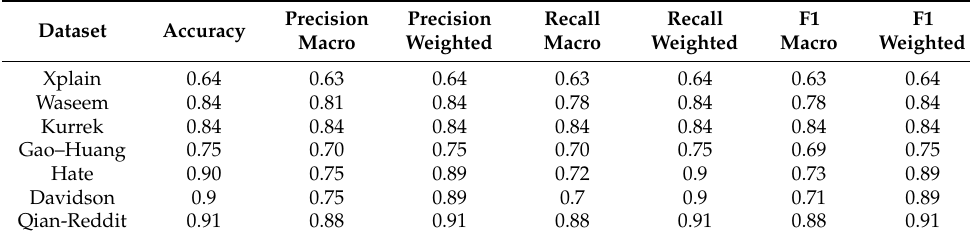
Table 3. MTL (fixed parameter) RoBERTa token embeddings.